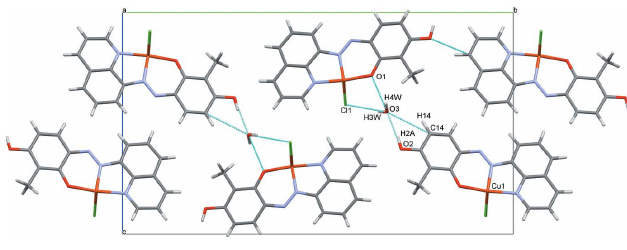
Figure 3 Crystal packing of the title compound viewed along the a axis showing intermolecular hydrogen bonds (blue dashed lines), generated with Mercury software (Version 2021.2.0; Macrae et al. , 2020).